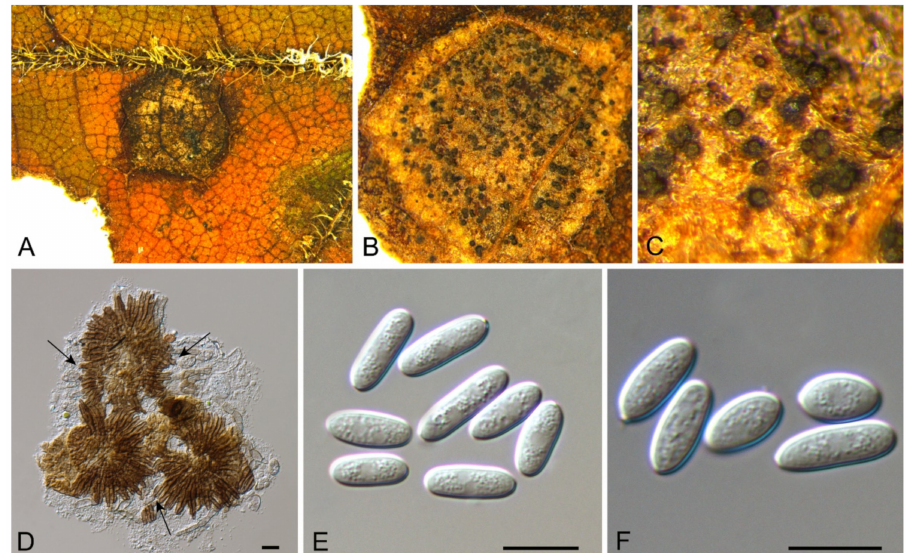
Figure 27. Tubakia dryinoides (BJFC-S1796). ( A – C ) Pycnothyria on the diseased leaves of Castanea mollissima ; ( D ) Conidio- genous cells giving rise to conidia; ( E , F ) Conidia. Scale bars: ( D – F ) = 10 µ